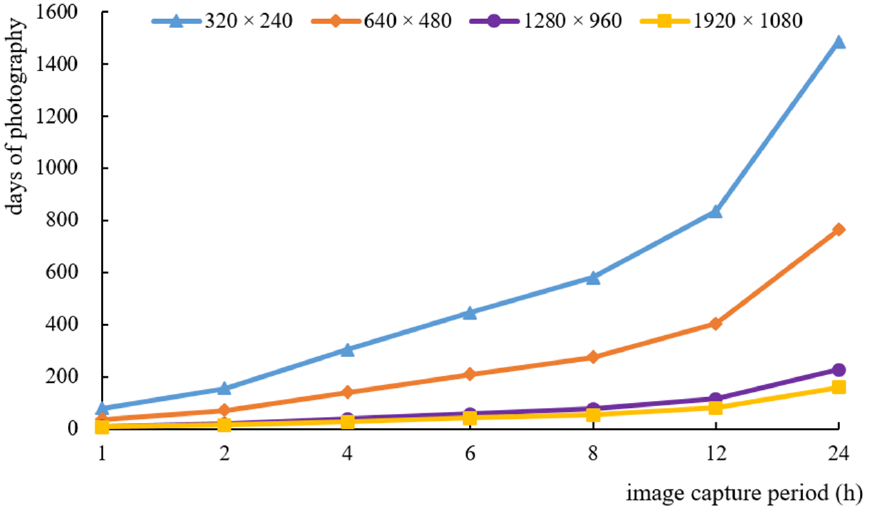
Figure 7. Days of photography with different image resolutions and capture periods of low-power monitoring device.